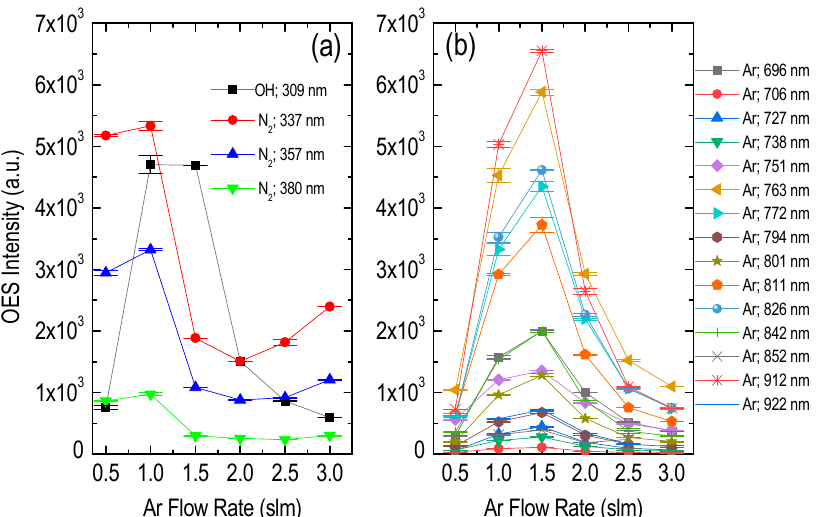
Figure 6. Optical emission intensity of the main emissive species detected as a function of the argon flow rate. ( a ) N 2 and OH species. ( b ) Ar species. Operational conditions: 11 kV pp and 17.5 kHz. Mean values and standard deviations are calculated from two series of experiments carried out on different dates.